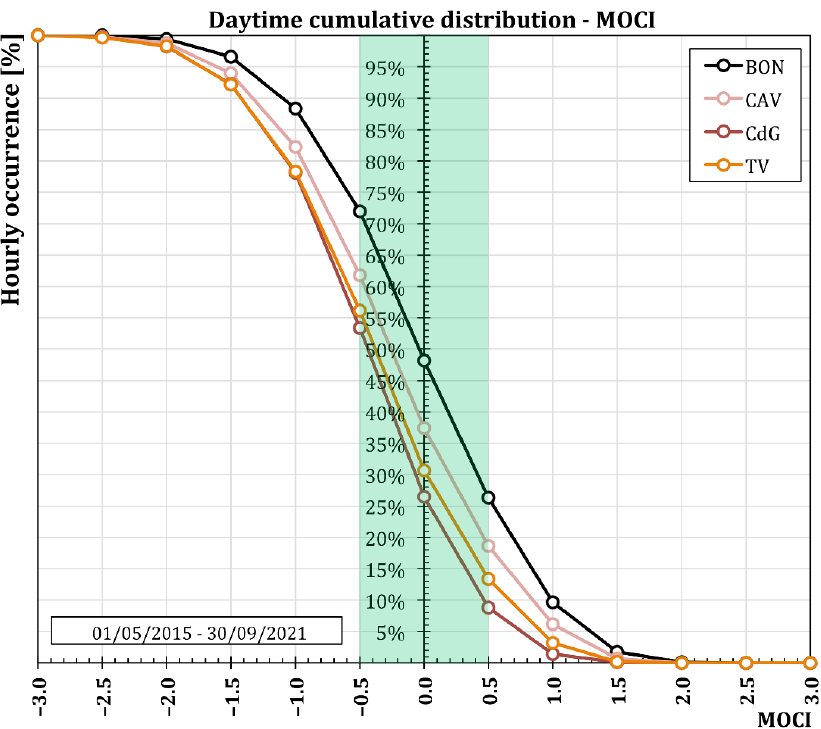
Figure 6. Cumulative distribution of average diurnal (from 06:00 to 19:00 LT) MOCI index for the four ARPA stations.